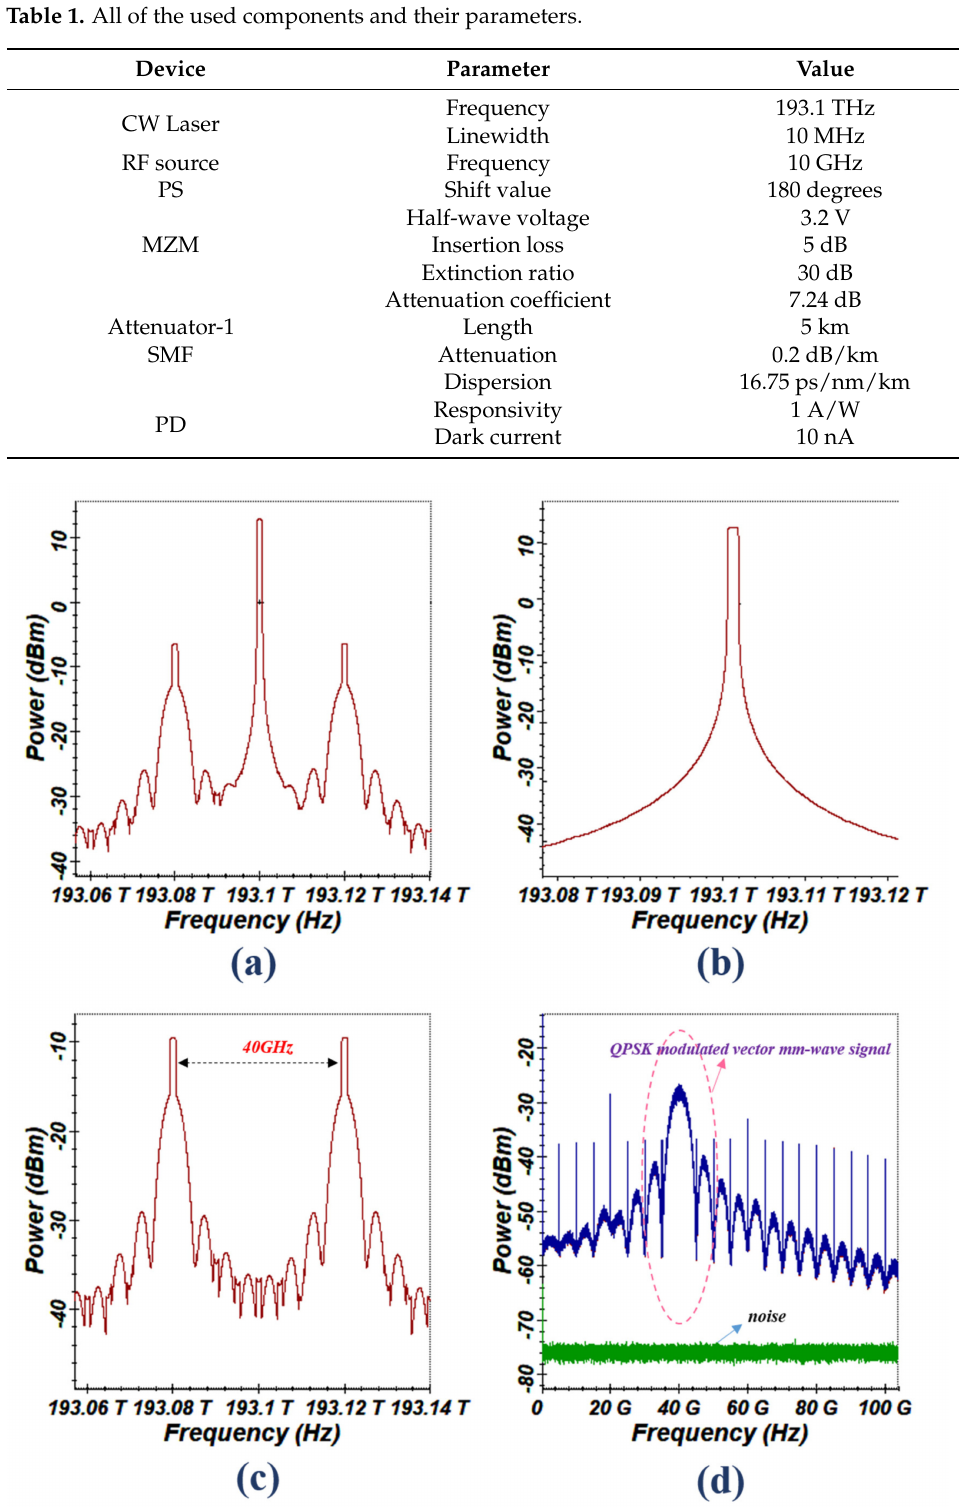
Figure 3. ( a ) Output optical spectra after MZM; ( b ) output optical spectra after CW laser; ( c ) output spectrum after eliminating the 0-order optical carrier; ( d ) electrical spectra of received QPSK vector signals after square-law